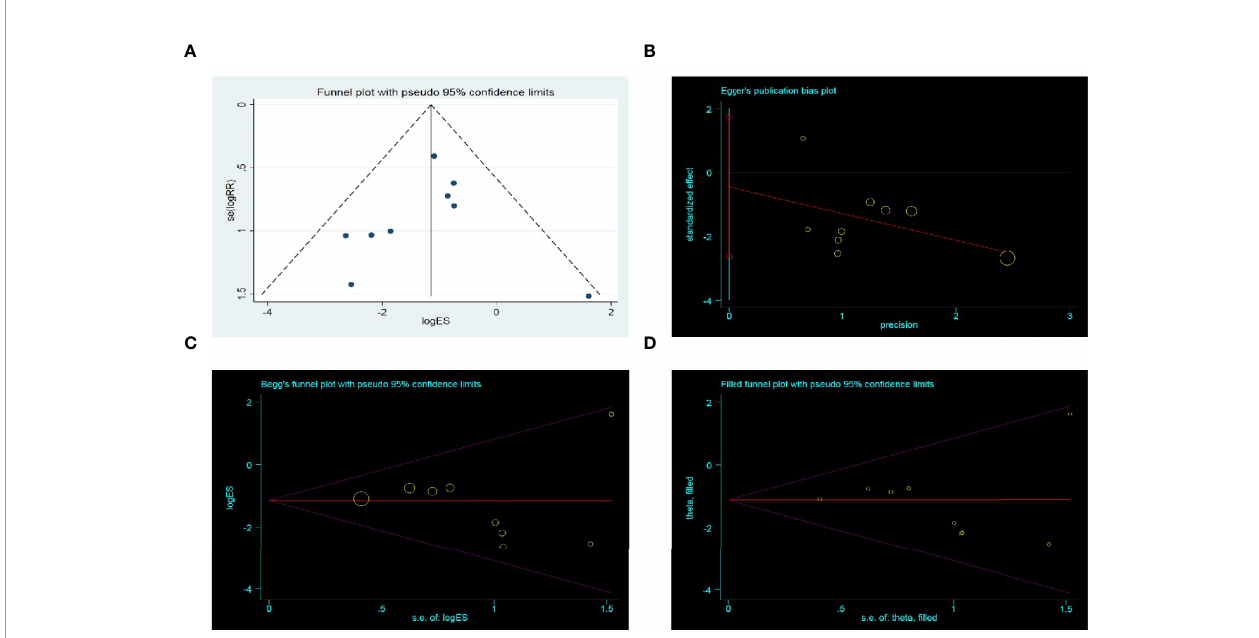
FIGURE 6 | Publication bias assessment. (A) Funnel plot; (B) Egger ’ s test funnel plot; (C) Begg ’ s test funnel plot; (D) Trim and fi ll funnel plot. Above four pictures were draw based on anastomotic leak